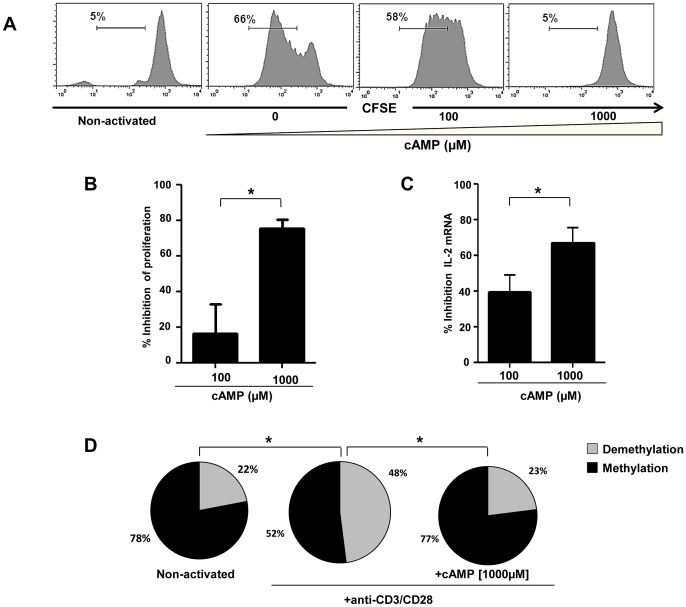
Inhibition of anti-CD3/CD28 mAbs stimulated naive CD4+ T cell proliferation and IL-2 production by cAMP.(A) Representative histograms showing the anti-CD3/CD28 stimulated proliferation of purified naive CD4+ T alone or treated with cAMP. Percentages of proliferating (CFSElow) CD4+ T cells are shown for each condition (one representative experiment out of 4 performed in triplicate); (B) Inhibition of CD4+ T cell proliferation by cAMP (pooled data of 4 experiments). (C) % Inhibition of IL-2 mRNA expression by cAMP (pooled data of 4 experiments). (D) The epigenetic changes on methylation of the essential CpG site of il-2 gene promoter. The cells were pre-incubated with cAMP before anti-CD3/CD28 activation in 3 independent experiments. 20–30 colonies were analyzed for each experimental condition. *P<0.05.